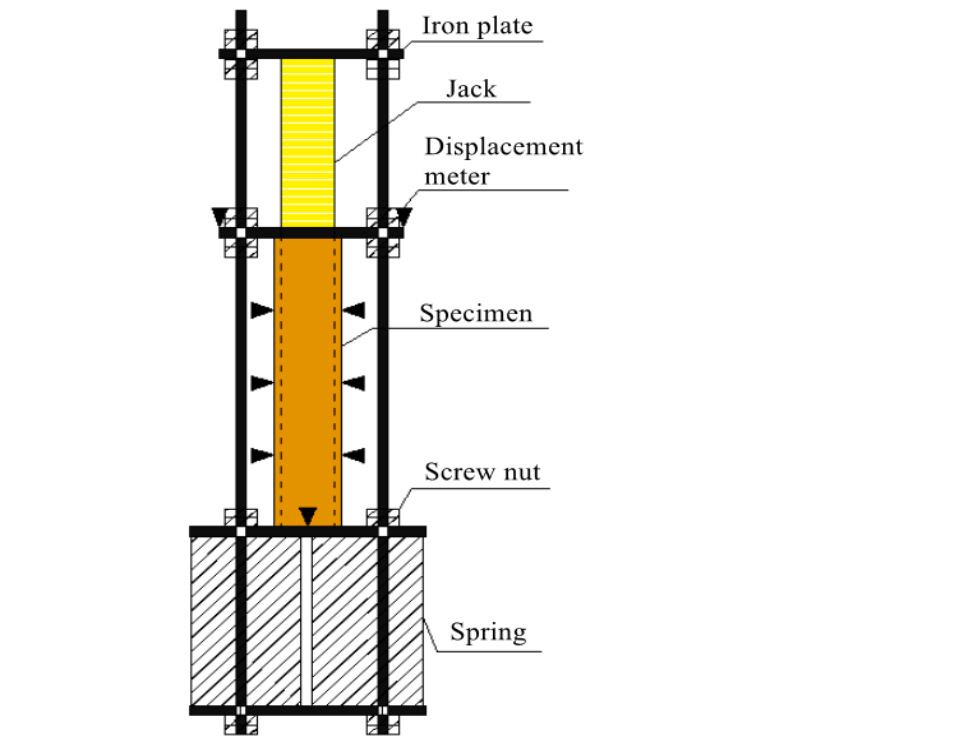
( b ) Figure 6. Creep-time curves under the same load conditions (without initial displacement): ( a ) The load level of 40%Ny; ( b ) The load level of 70%Ny. 3.2. Compression Deformation-Time Curves with Initial Displacement In order to study the proportion of creep in the total deformation, compression de- formation-time curves including the initial displacement were drawn (Figures 7 and 8). Figure 7 shows the creep-time curves of the same cross-section, and Figure 8 shows the creep-time curves of the same load.